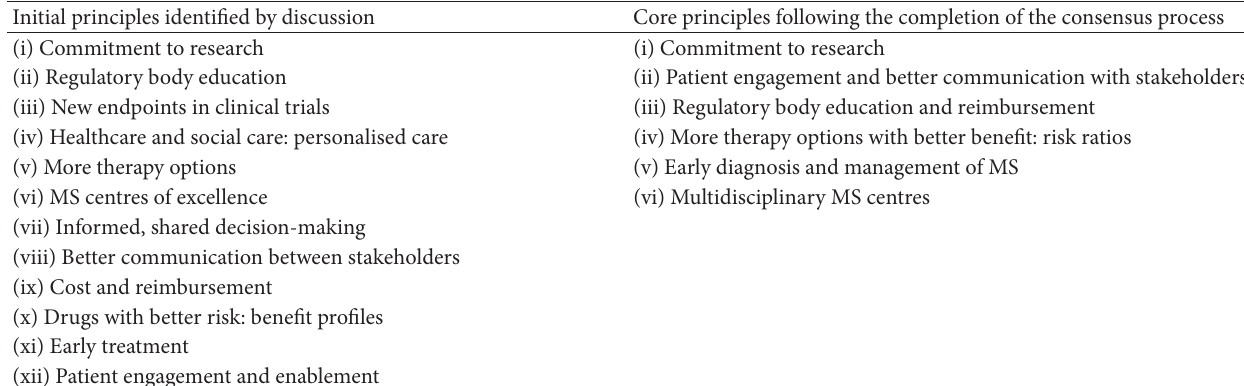
Initial principles identified by